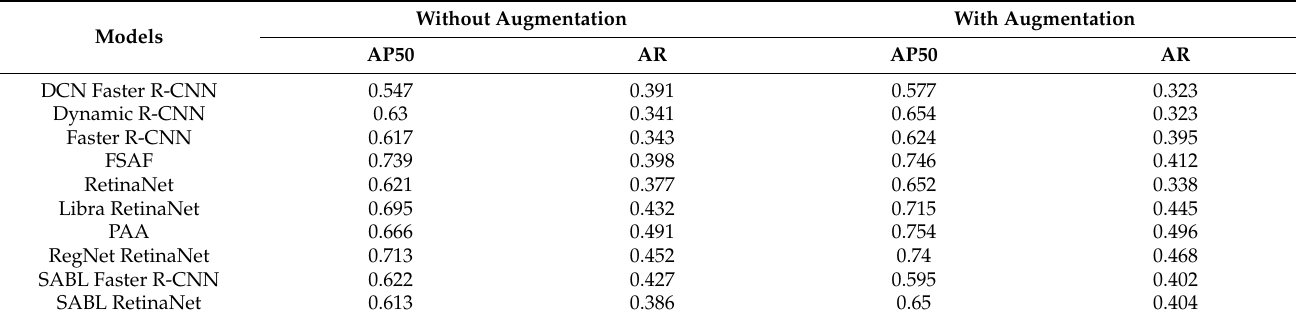
Table 8. Test AP50 and AR results of detection